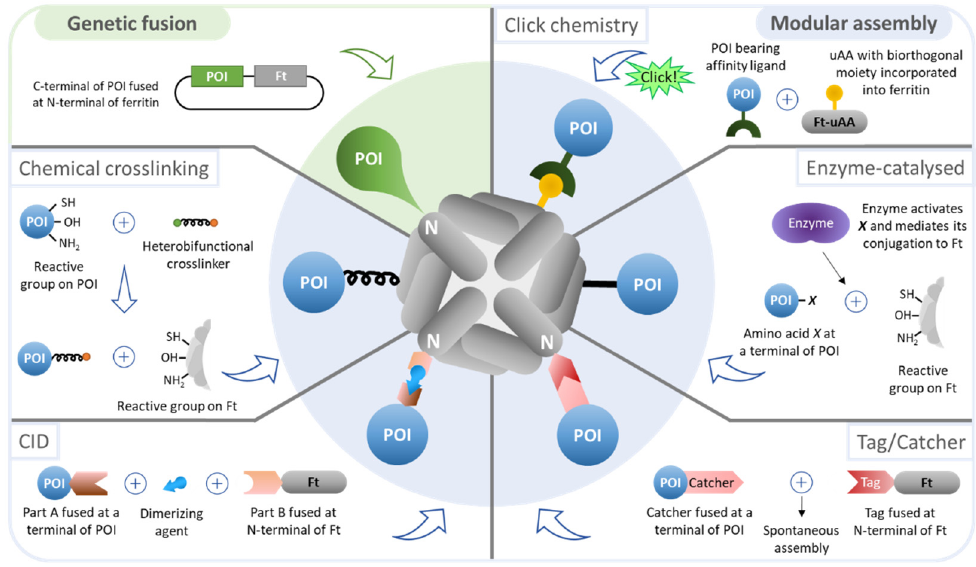
Figure 3. Technologies used for the design of functionalized ferritin nanoparticles. The outer surface of ferritin (Ft) nanoparticles can be functionalized with a protein of interest (POI) by genetic fusion (green-shaded) and modular assembly (blue-shaded). CID—chemically inducible dimerization.